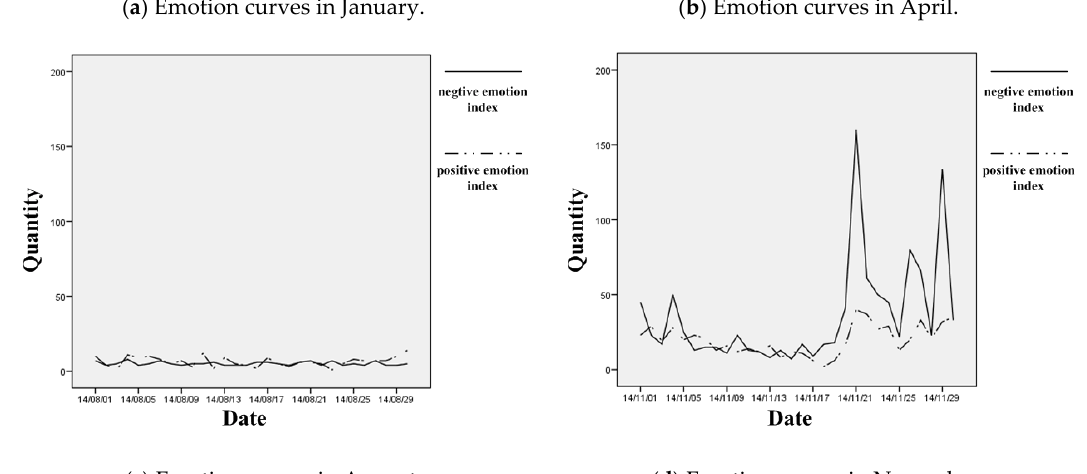
Table 5. Statistics of the emotion indexes in the four sample months.